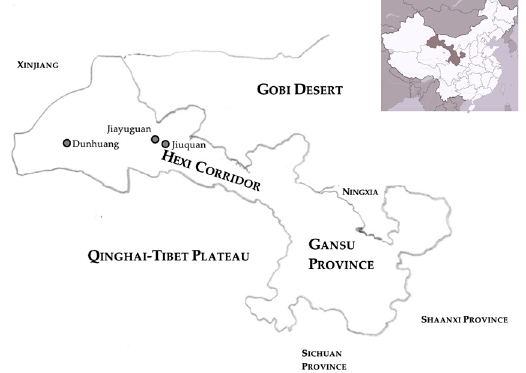
Figure 1. Map of the Hexi Corridor and Gansu Province.